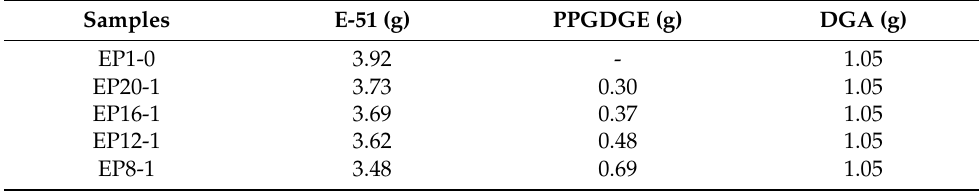
Figure 1. Chemical structure of thermoplastic epoxy shape memory polymer ( a ) without PPGDGE, or with PPGDGE ( b ). Table 1. Composition of thermoplastic epoxy shape memory polymer EPx series.